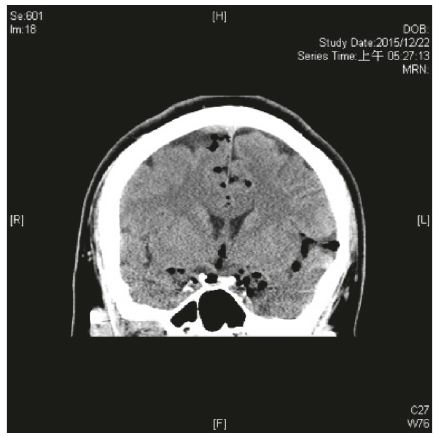
Figure 1: Coronal view of the CT scan reveals opacification of left ethmoid and maxillary sinus, indicating left chronic sinusitis. Note the air bubble in the left olfactory fossa, which gives us a hint of the possible site of breach in the lateral lamella of cribriform plate on patient’s left side.